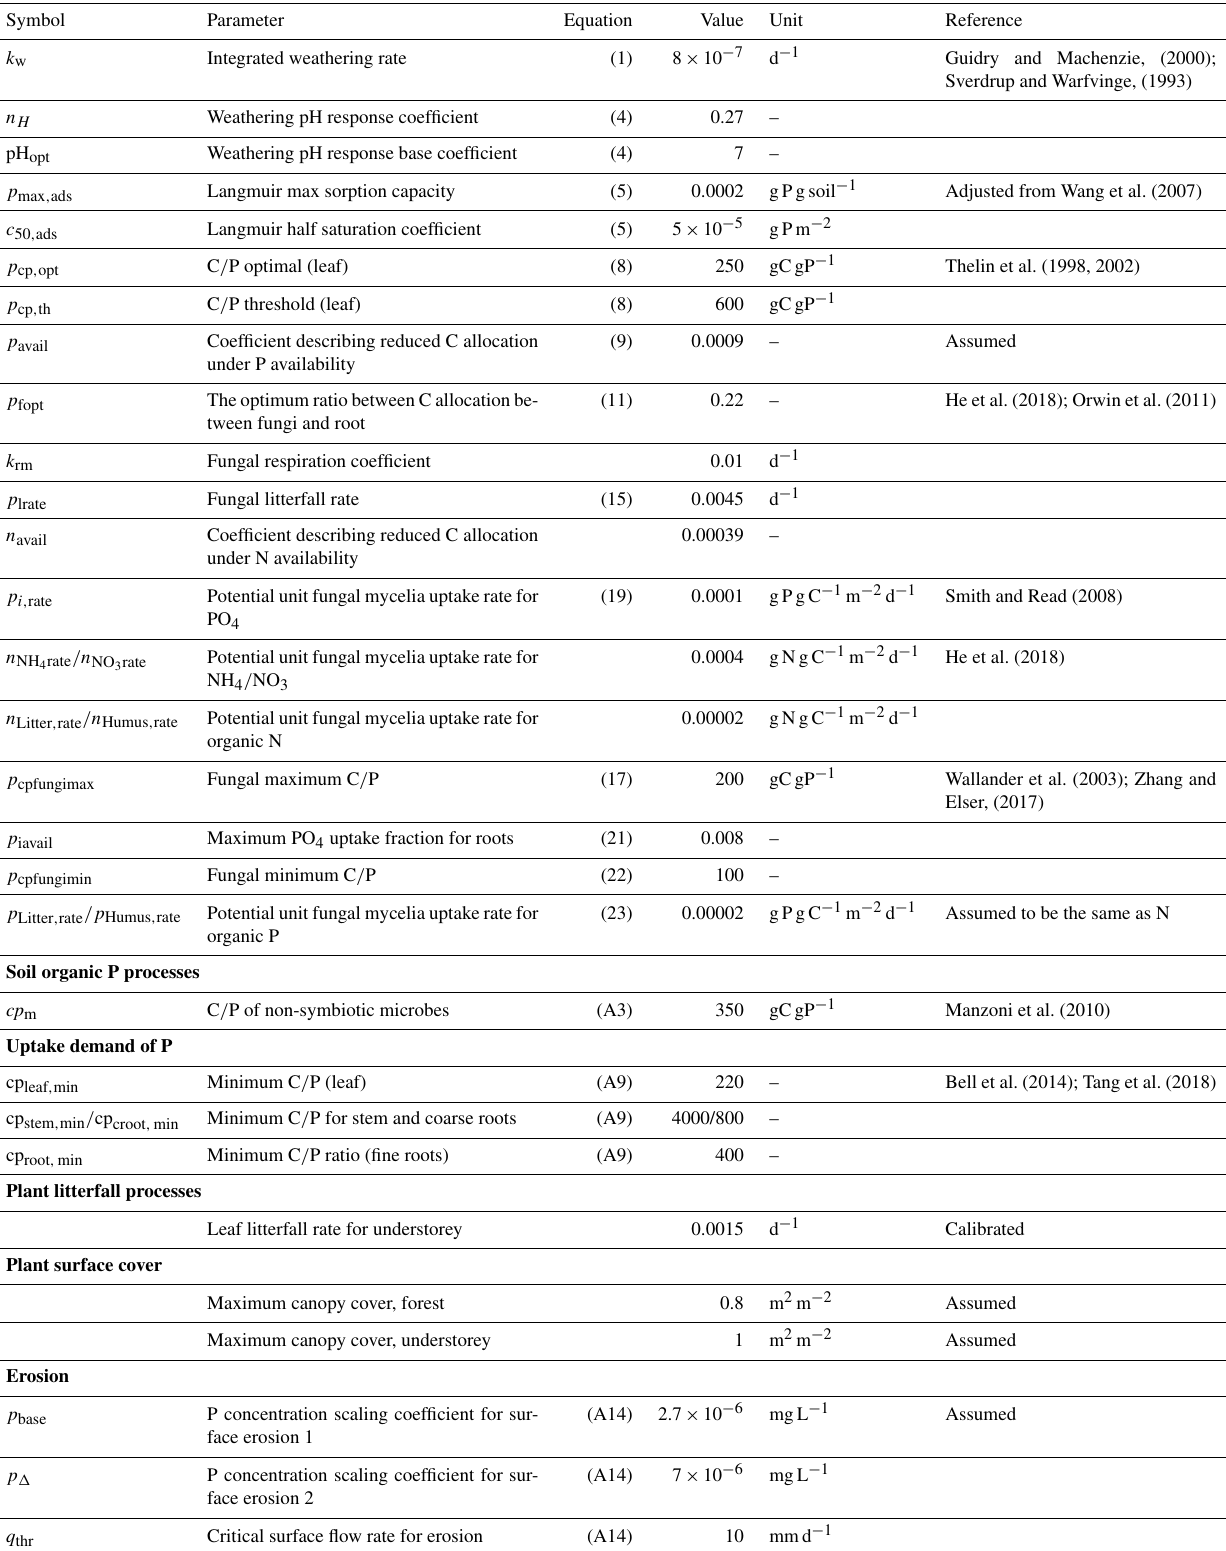
Table 3. Parameters used for the default model run for the P processes with common values across all four studied regions. Note that the same parameter values were applied for tree and understorey layers unless otherwise